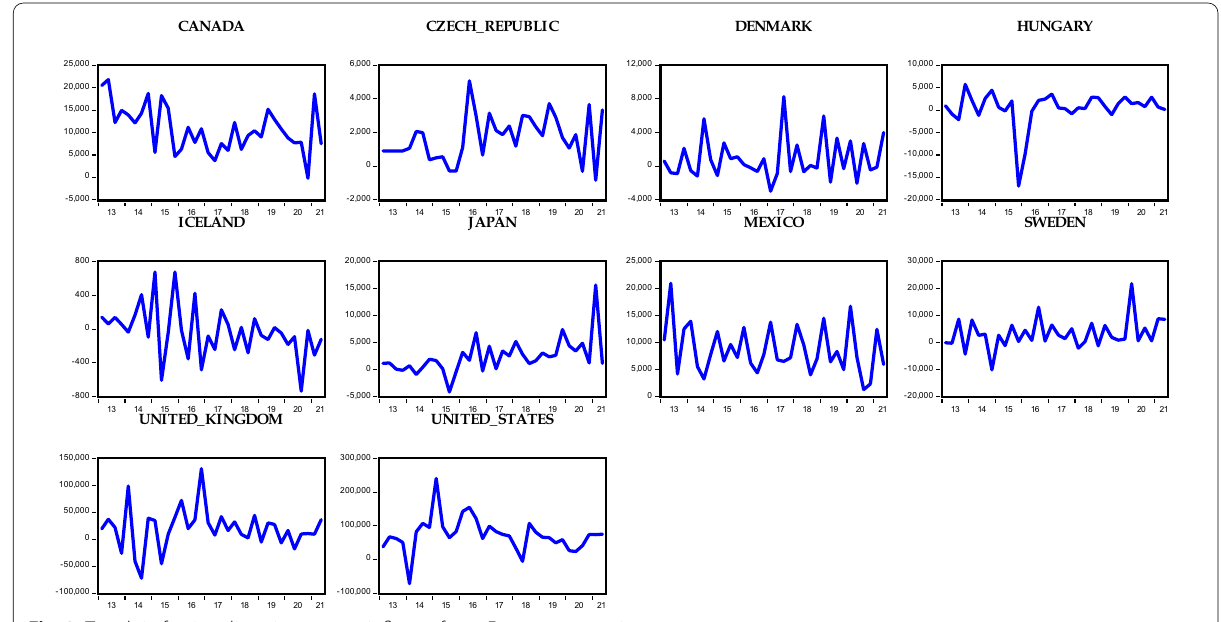
Fig. 2 Trends in foreign direct investment inflows of non-Eurozone countries